Question: What does this figure show? Answer in one sentence.
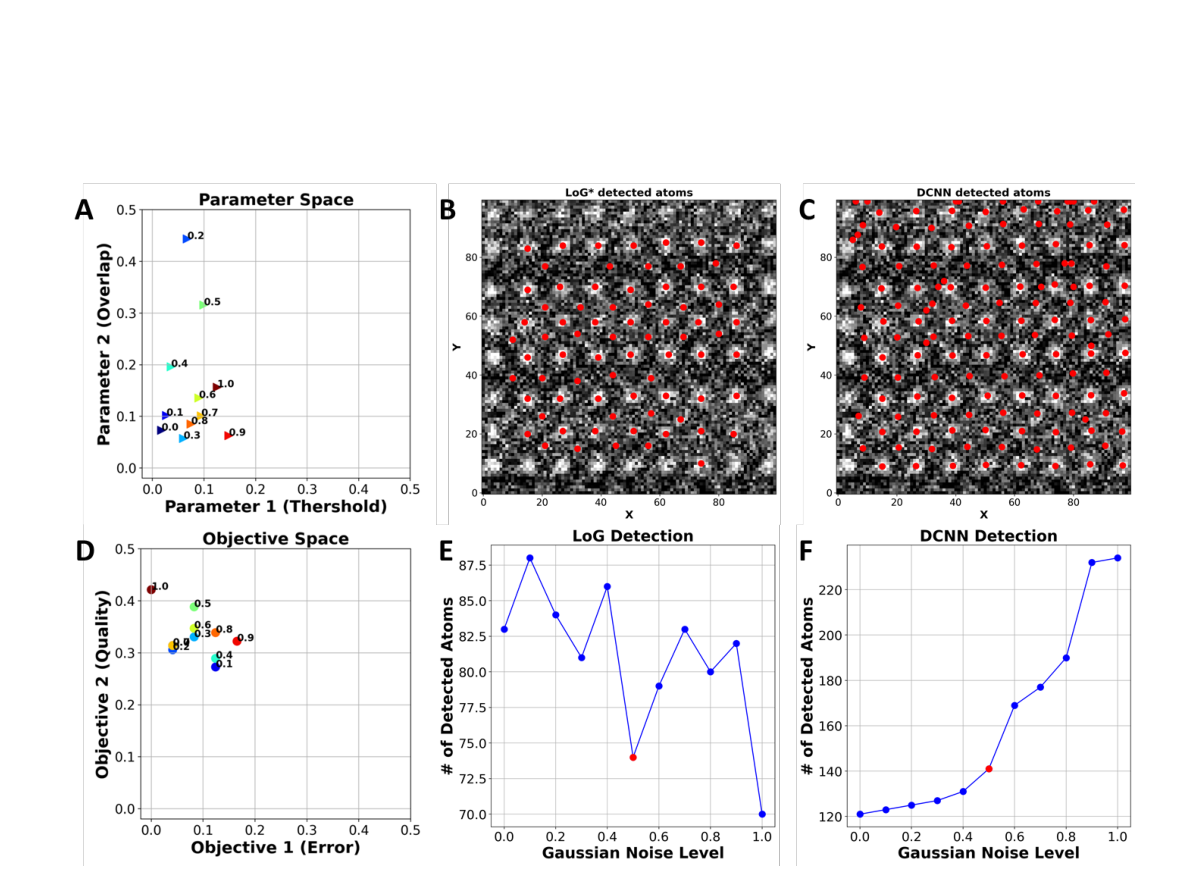
Answer: A) Optimal hyper-parameter space changes verses noise level in the LoG* optimized  method, B) Detected atoms using the LoG* optimized method on the image with a moderate noise  level, C) Detected atoms using a (DCNN) model scattered on the image, D) Optimal objective  space change verses noise level in the LoG* optimized method, E) Number of detected atoms  versus Gaussian noise level using the LoG* optimized method, F) Number of detected atoms  versus Gaussian noise level using a (DCNN) model.